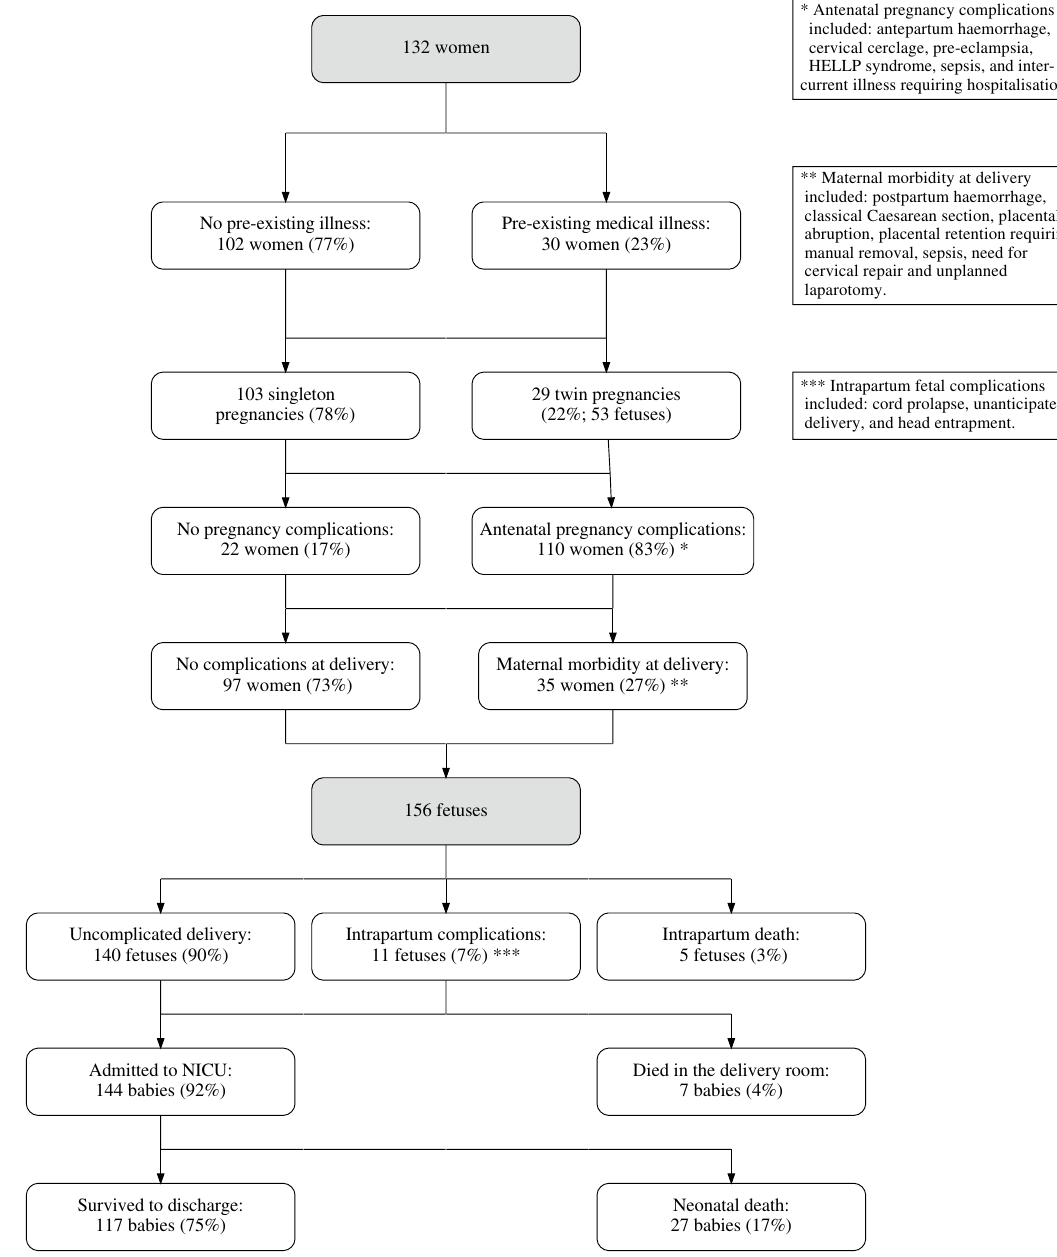
Figure 1. Flow chart of women and fetuses/babies (alive at the onset of labour or when a decision was made to perform Caesarean section) delivered at 22 + 0 to 26 + 6 completed weeks of gestation at University College London Hospitals NHS Foundation Trust between 1st January 2011 and 31st December